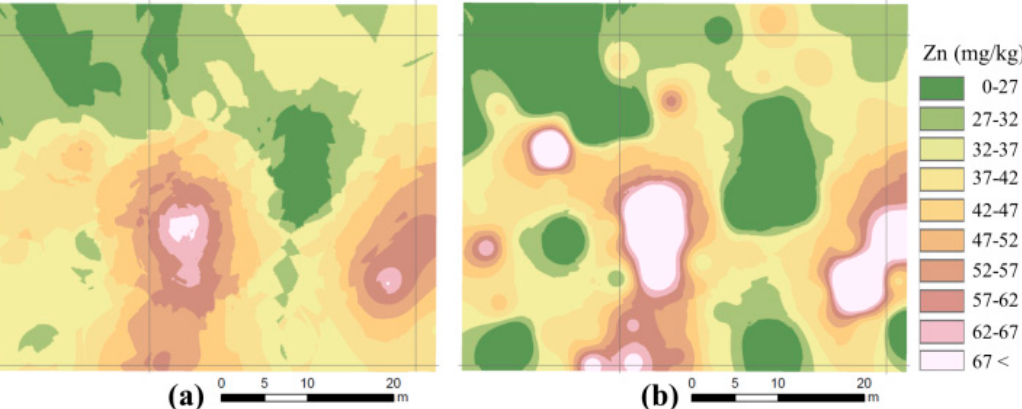
Figure 7. Sand contamination map of Zn. ( a ) Kriging result and ( b ) IDW result. 210